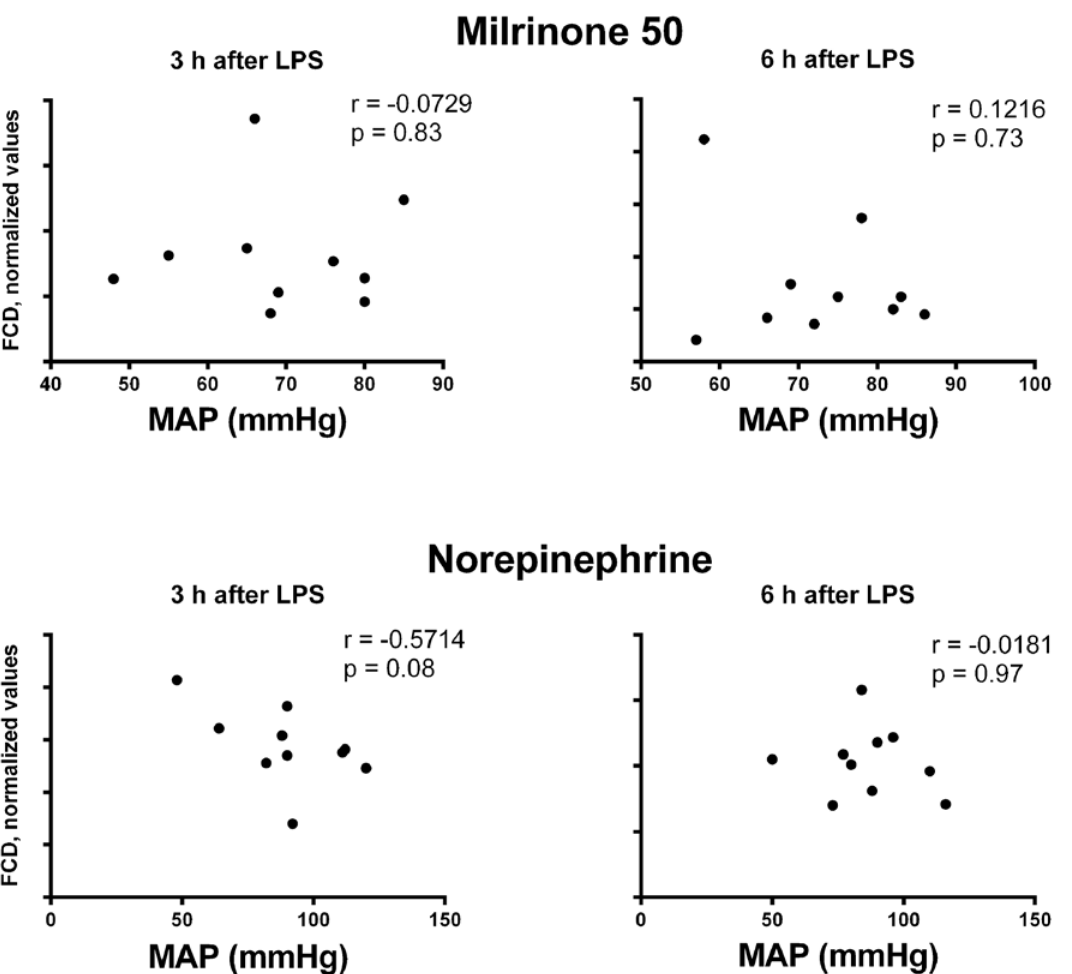
Fig 6. Scatter plots of correlations between functional capillary density (FCD) and mean arterial pressure (MAP). Spearman correlation coefficient and p values are shown for each correlation. n = 10 per time point and per